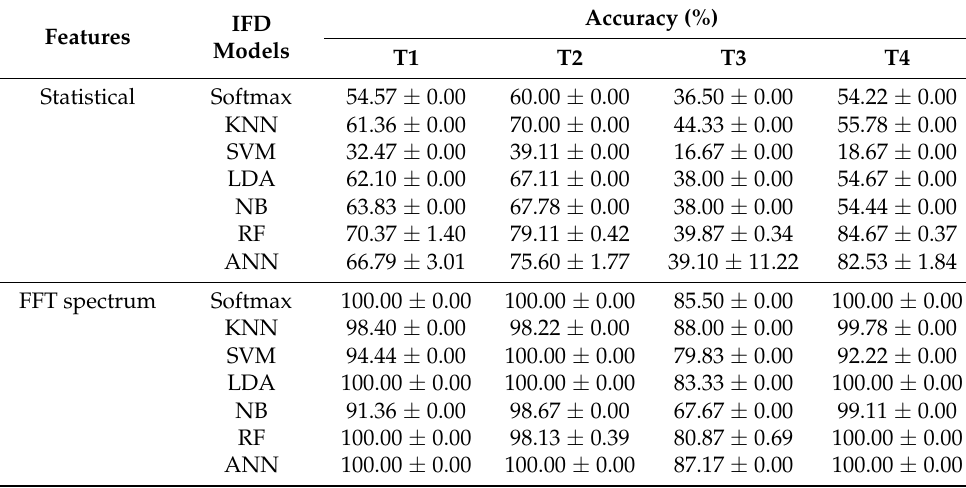
Table A1. The diagnostic accuracies on gearbox dataset.